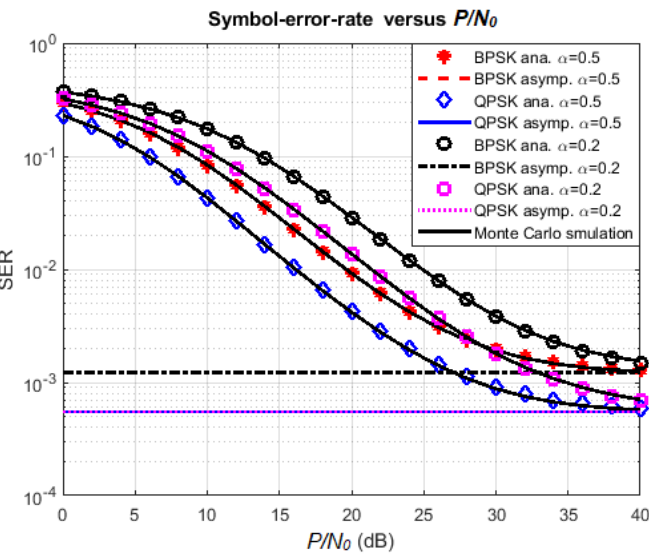
Figure 10. Effect of α and modulation scheme on